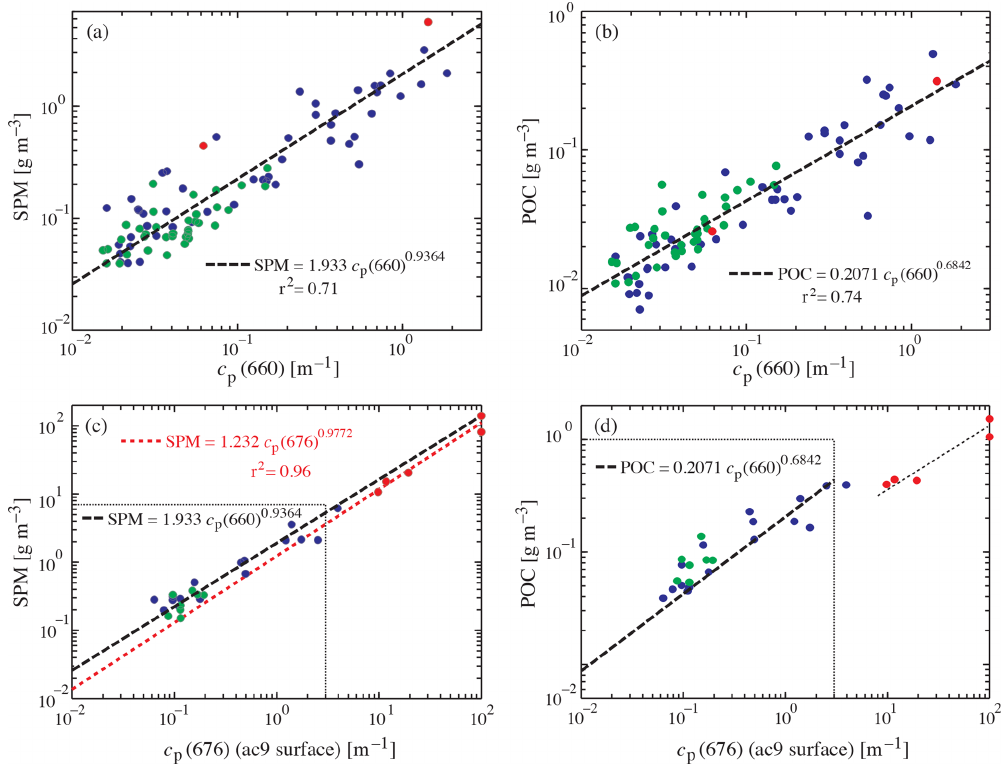
Figure 6. SPM and POC as a function of particulate beam attenuation coefficient at 660nm based on measurements from CCGS Amundsen during the MALINA expedition in 2009 (a–b) and as a function of the particulate beam attenuation coefficient at 676nm measured with the AC-9 from the barge (c–d) (the latter data contain only surface samples). The dotted squares in (c) and (d) indicate axis limits in (a) and (b) , respectively. The colors of the data points indicate POC / SPM categories: mineral dominated (red), mixed (blue), and organic dominated